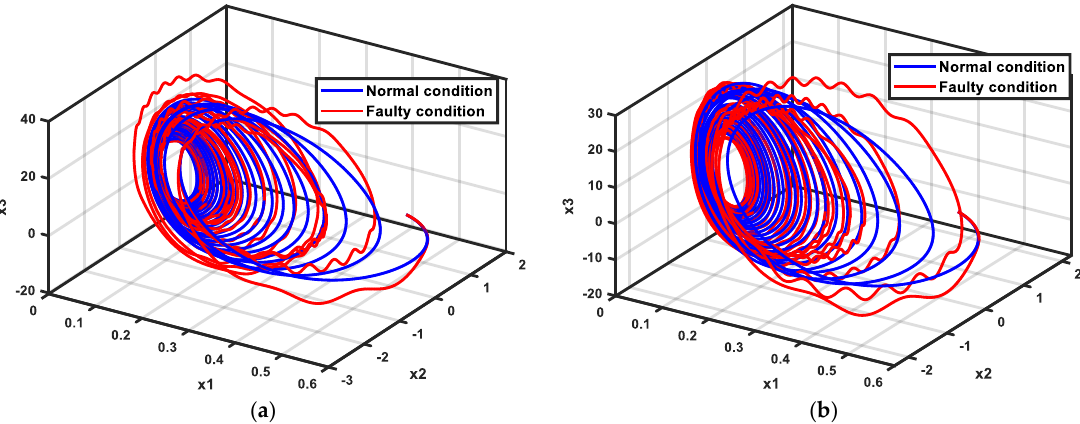
Figure 3. Comparison of SG trajectories in normal and fault modes: ( a ) actuation fault, ( b ) fault impacted on the system dynamics.